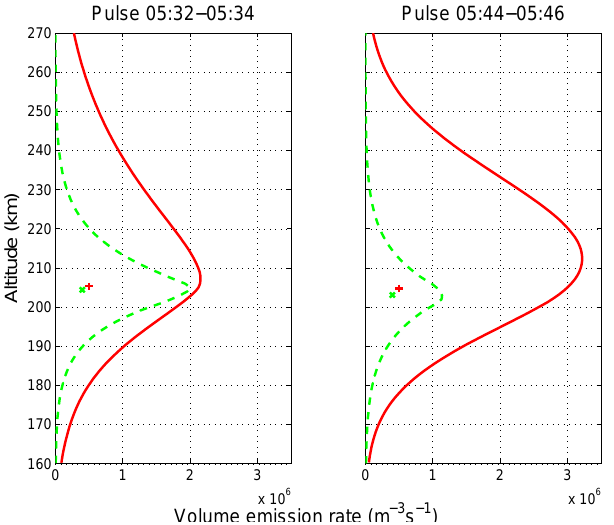
Fig. 10. The altitude variation of the enhanced emissions agrees well with the theoretical calculations (e.g. Bernhardt et al., 2000; Gustavsson and Eliasson, 2008) with center of emission a few kilometer above the center of excitation for 5577 ˚A (dashed green curve) and ∼ 15km for 6300 ˚A (solid red curve). Further, the width in altitude is 7–15km wider for 6300 than 5577 ˚A. The centers of excitation are shown as +(6300 ˚A) and x (5577 ˚A).